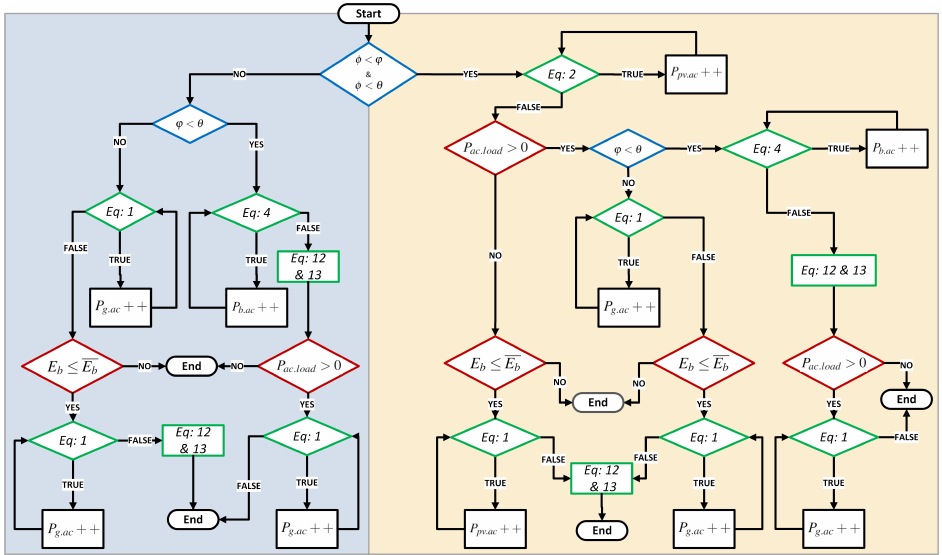
Figure 7. Case II flow chart.